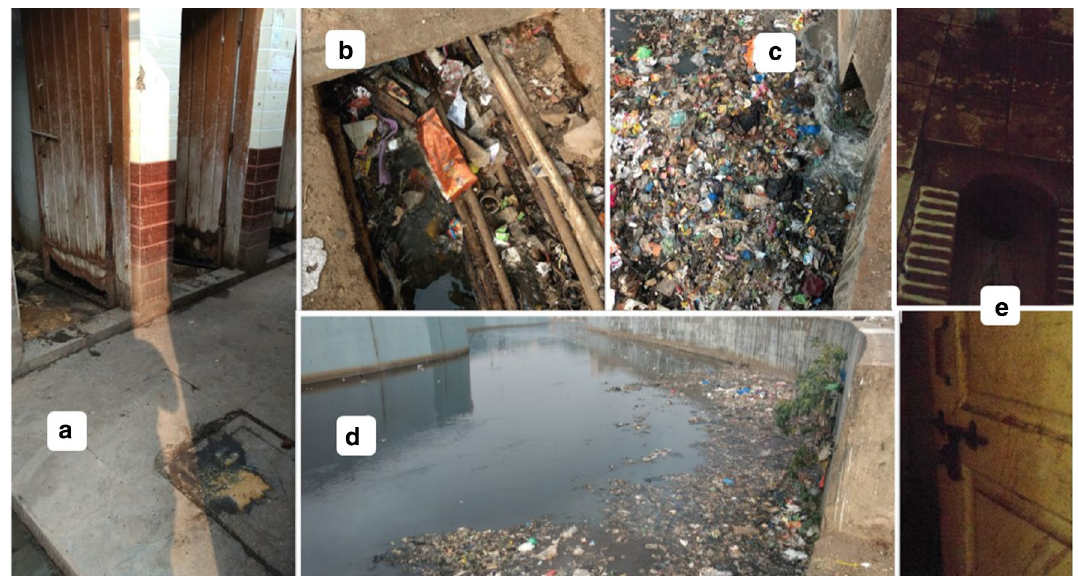
Fig. 4 a People have excreted outside the toilet seat, b white pipes carrying drinking water, c black water from the toilet block comes out and flows through a small nallah, then big nallah or drain and finally